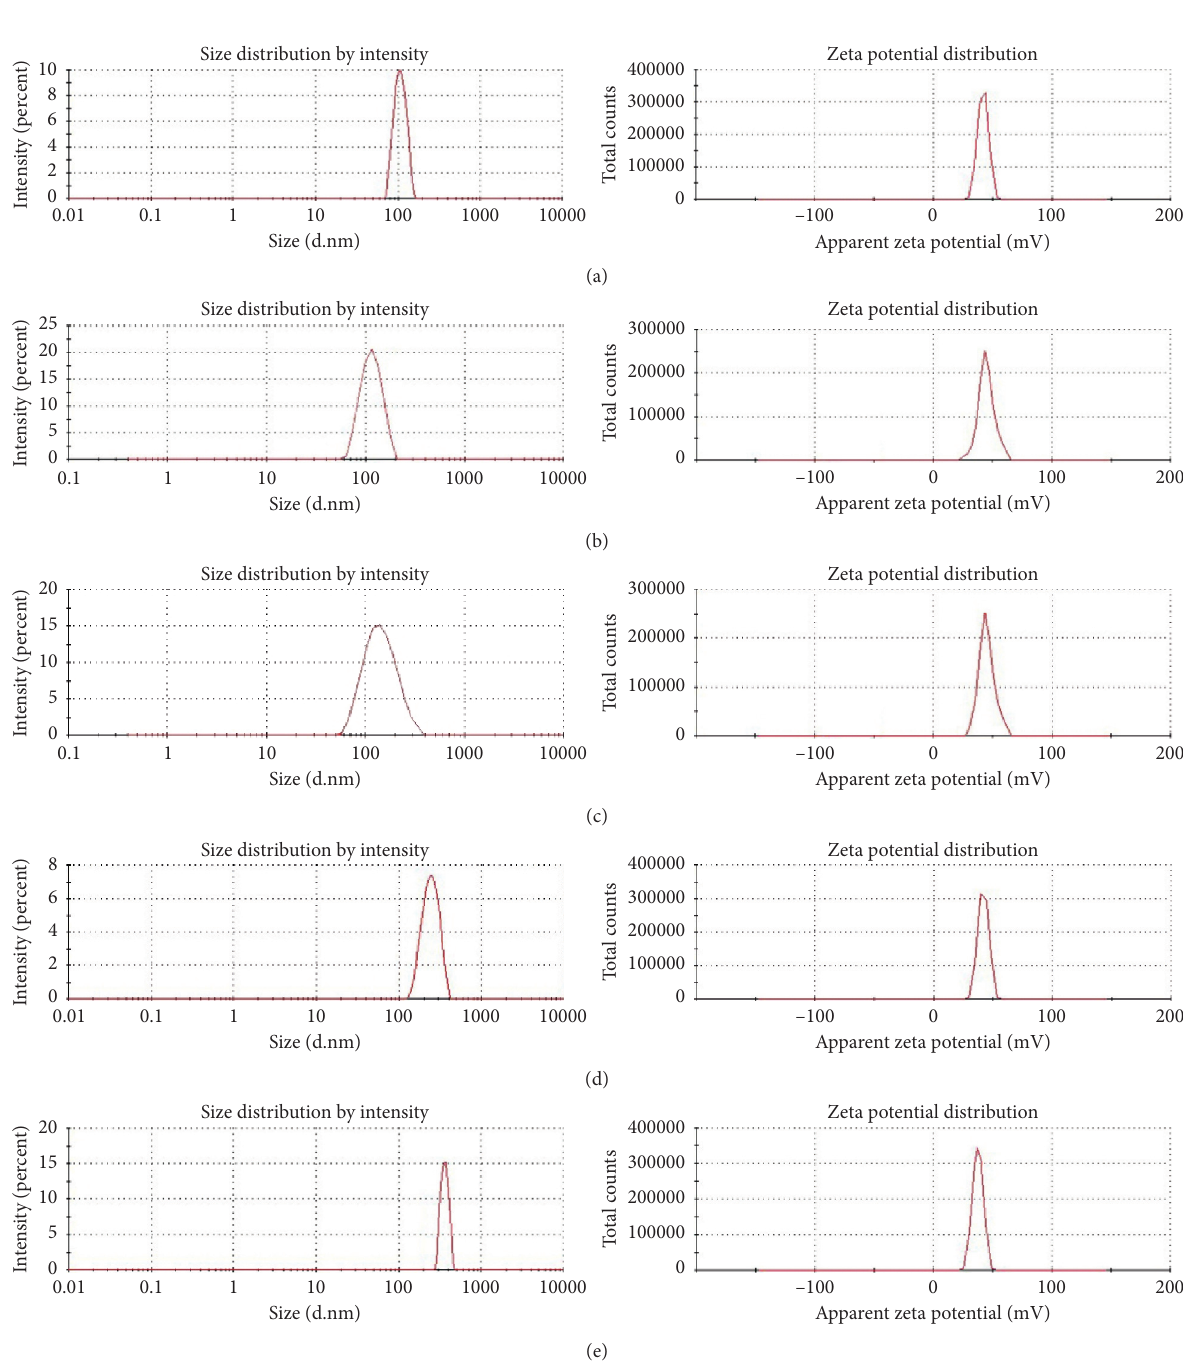
Figure 2: Size distribution intensity and zeta potential distribution intensity graphs of CS-NP and CS-NP-GT synthesized with different ratios of CS :GT: (a) CS :GT � 1: 0; (b) CS: GT � 1: 0.25; (c) CS :GT � 1 :0.5; (d) CS :GT � 1 :0.75; (e) CS: GT �